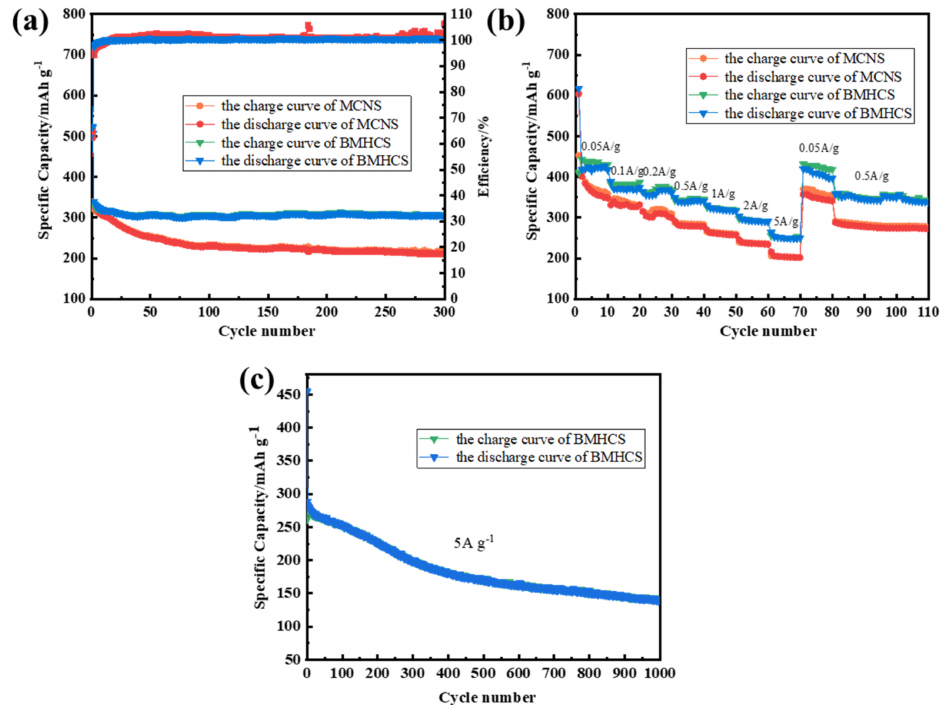
Figure 7. ( a ) Cycling performance of MCNS and BMHCS at 1 A g − 1 ; ( b ) Rate performance of MCNS and BMHCS from 50 mA g − 1 to 5 A g − 1 ; ( c ) Cycling performance of BMHCS at 5 A g − 1